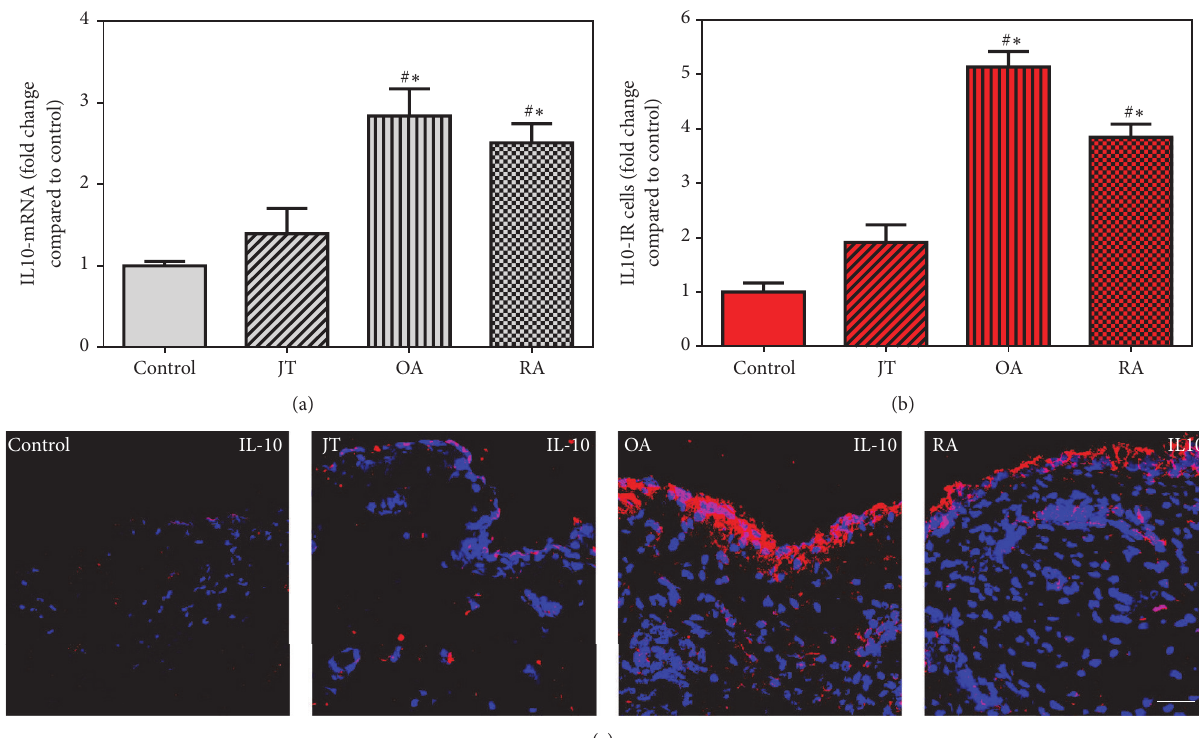
Figure 4: Detection of IL10 mRNA (a) and number of IL10-IR cells (b and c) in patients with joint trauma (JT), osteoarthritis (OA), and rheumatoid arthritis (RA). (a) Quantification of IL10 mRNA shows that IL10 mRNA was significantly higher in RA and OA compared to JT and control synovium ( 𝑃 < 0.05 , one-way ANOVA followed by Tukey’s test). (b) Quantitative analysis of immunofluorescence microscopy for IL10-IR cells. ∗ Relative to control, # relative to other groups ( 𝑃 < 0.05 , one-way ANOVA followed by Tukey’s test). Data are shown as means ± SEM. (c) 5-LOX-IR cells are more abundant in RA synovium than in JT, OA, and control synovium. Bar = 20 𝜇